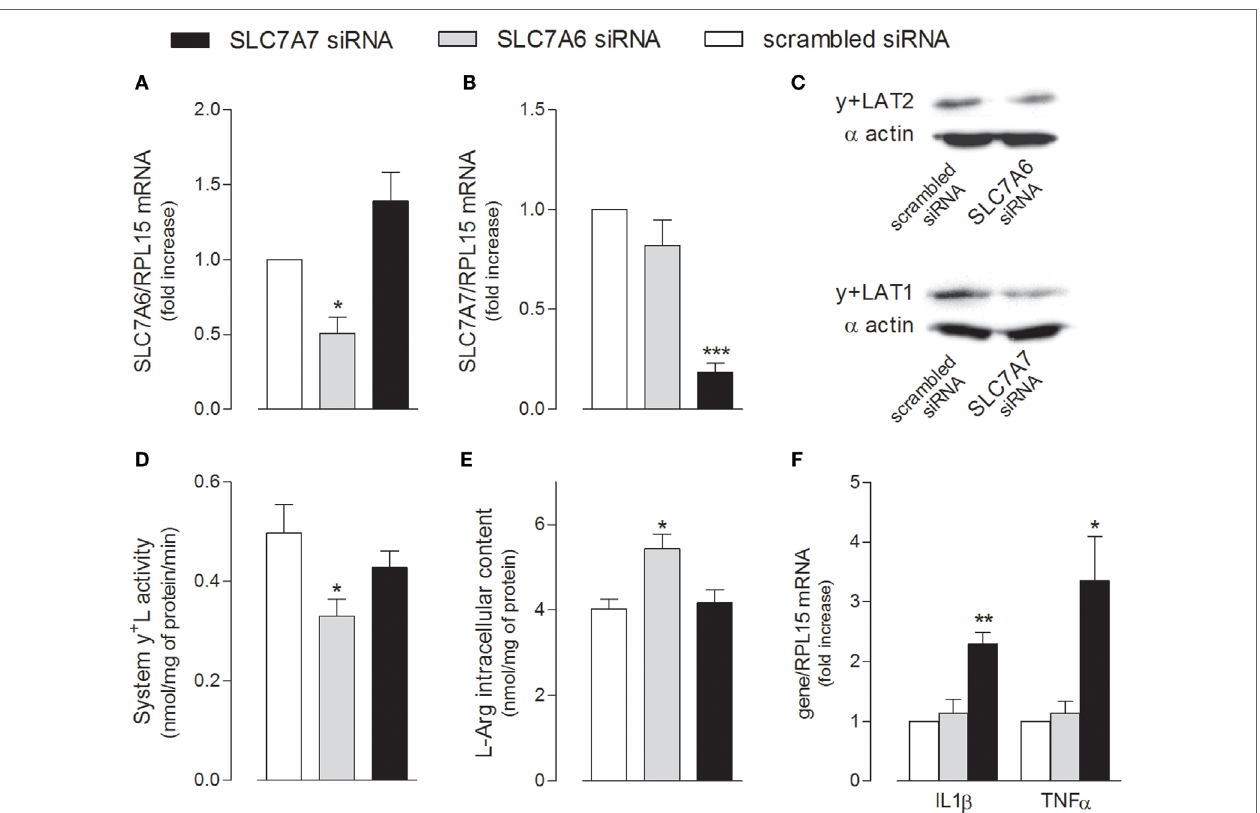
FigUre 5 | A549 cells were transfected with scrambled, SLC7A6 or SLC7A7 short interference RNA (siRNA), as described in Section “Materials and Methods.” The expression of SLC7A6 (a) , SLC7A7 (B) , and IL1B and TNFA (F) mRNA was measured with RT-qpolymerase chain reaction (RT-qPCR); data are mean ± SEM of three independent determinations, each performed in duplicate. Protein levels of y + LAT2 and y + LAT1 were determined with Western Blot analysis (c) ; a representative blot is shown. The transport activity of System y + L (D) and arginine intracellular content (e) were also measured, as described in Section “Materials and Methods”; data are mean ± SEM of four independent experiments, each performed in quadruplicate. * p < 0.05, ** p < 0.01, *** p < 0.001 vs . scrambled siRNA with one-way ANOVA followed by Bonferroni post hoc